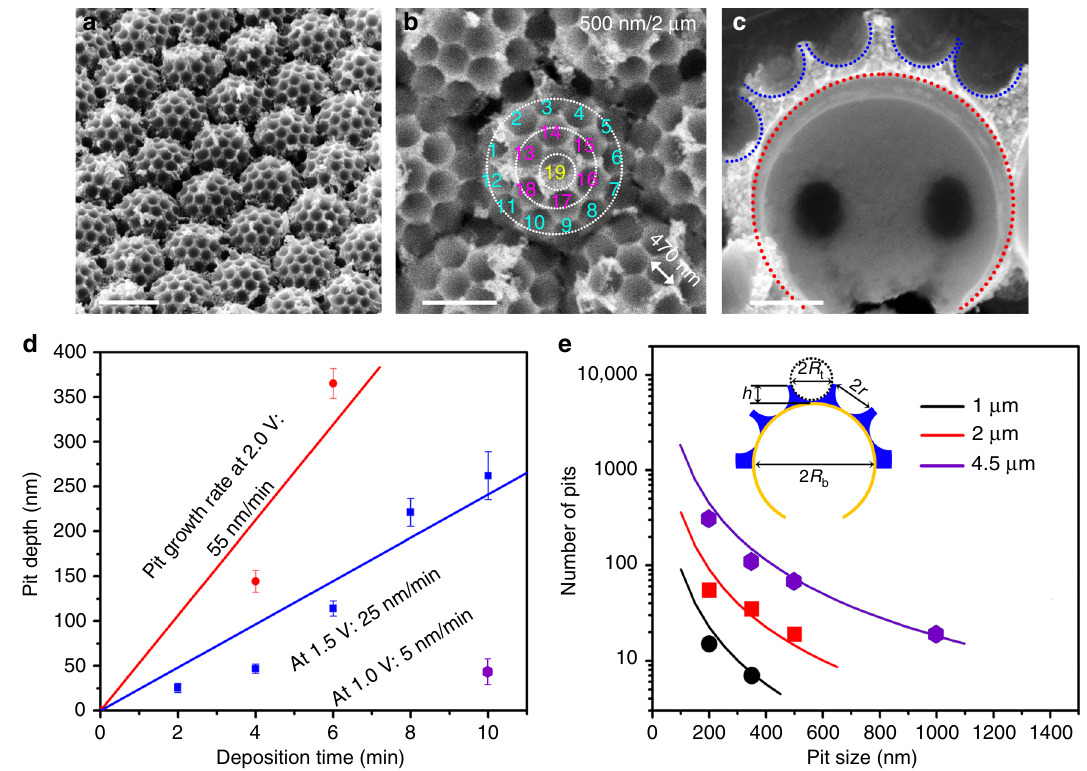
Fig. 3 Structural control of BCs. a , b SEM images of Ag BCs at different magni fi cations. Scale bars: ( a ) 2 µ m, and ( b ) 1 µ m. c Cross-sectional image of a silver brochosome particle. Scale bar: 500 nm. d A plot showing the growth rate of pit depth at different electrodeposition voltages. Error bars represent standard deviations from 100 independent measurements of the pits. e A plot showing the relationship between the number of pits and the pit size on the brochosome particles for a given size of bottom layer spheres (labeled in inset). Solid lines indicate theoretical predictions. Inset showing the schematic of the relevant geometrical parameters of a brochosome-like